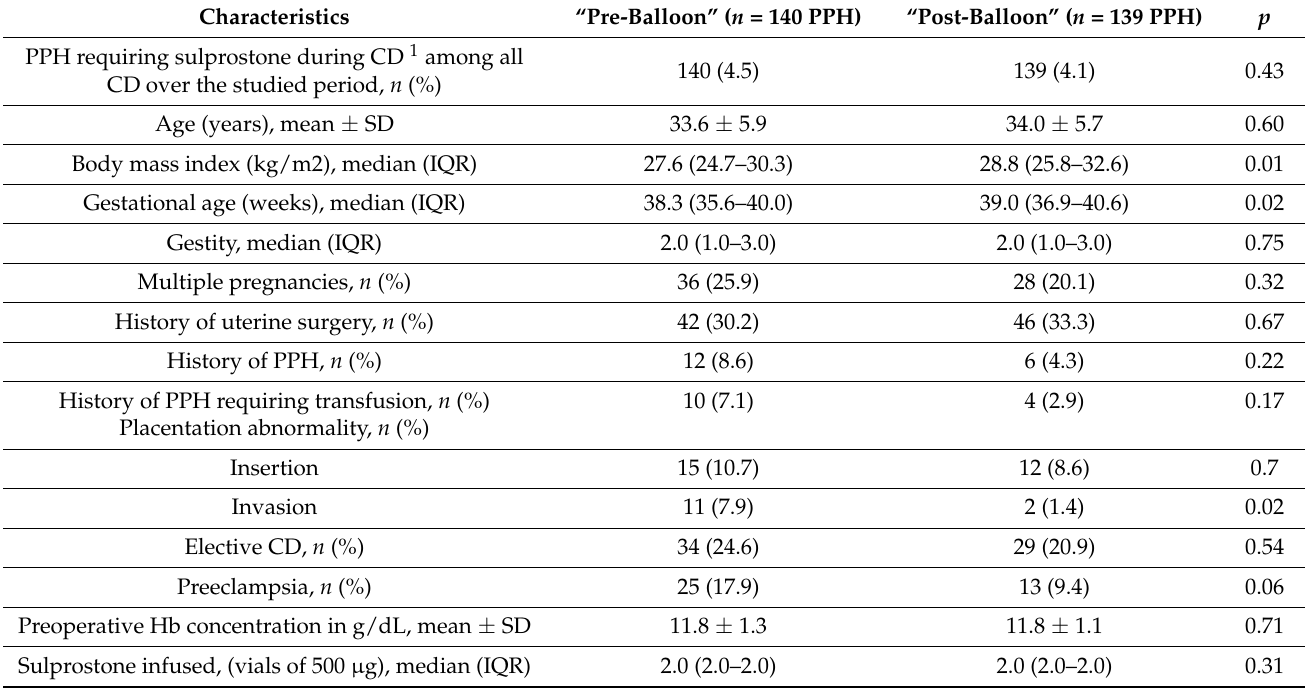
Table 1. Detailed characteristics of patients with PPH included .